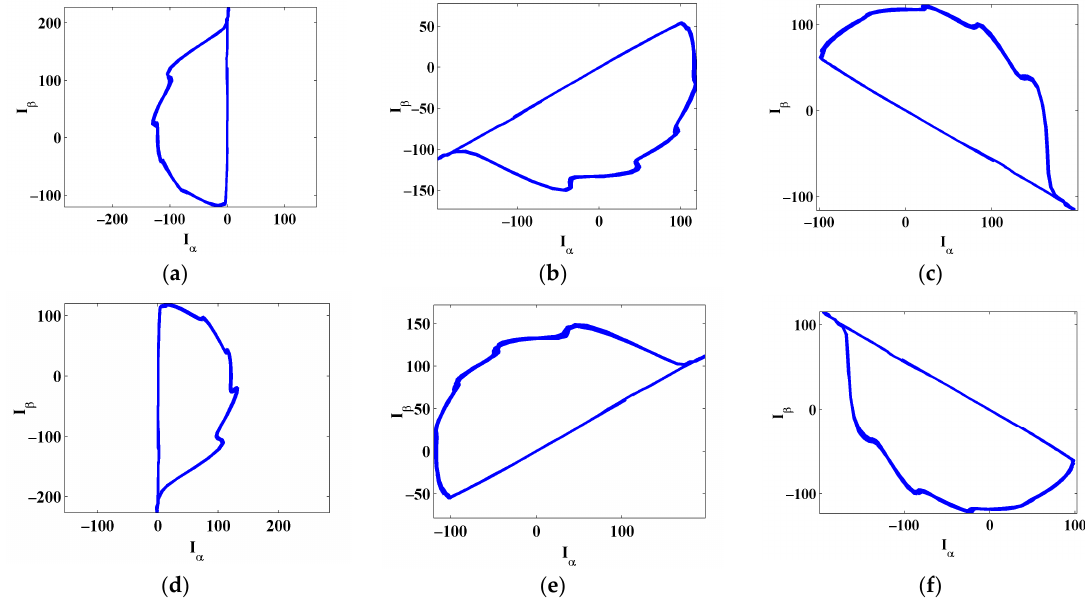
Figure 4. Trajectory of stator current with an open circuit fault at 1000 rpm/100 Nm: ( a ) Open circuit fault in T1; ( b ) Open circuit fault in T2; ( c ) Open circuit fault in T3; ( d ) Open circuit fault in T4; ( e ) Open circuit fault in T5; and ( f ) Open circuit fault in T6.